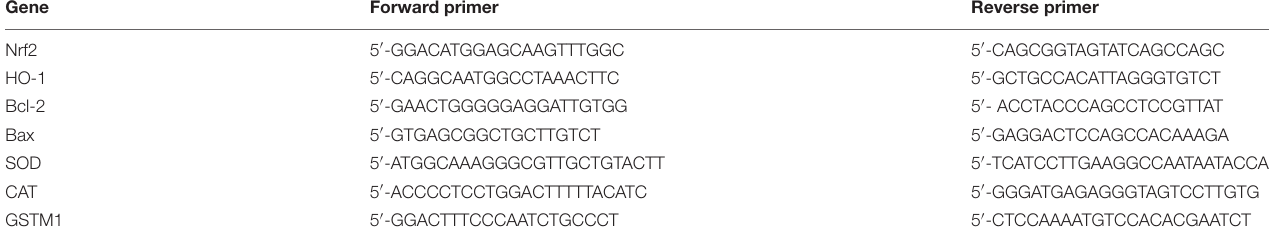
TABLE 2 | List of quantitative real-time PCR primers used in the study.